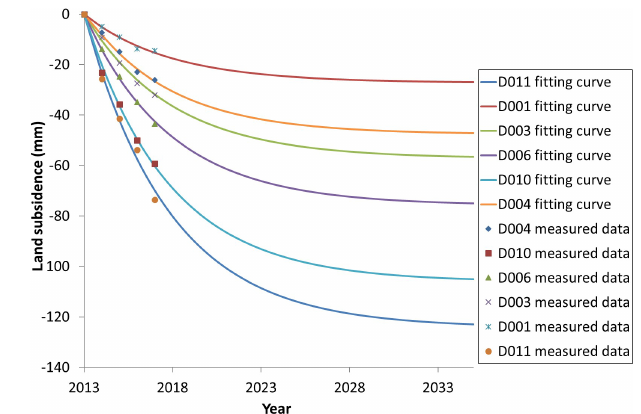
Figure 6. Fitting and forecasting curves of land